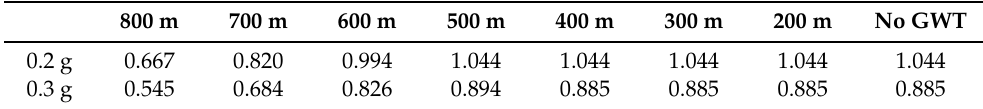
Figure 9. Sliding surfaces for different levels of the groundwater table under the seismic acceleration of 0.2 g (the slip surface corresponding to the GW table with black underlines in the legend is closest to the observed slip surface). Table 9. The safety factors of the slope under different initial groundwater table conditions for the seismic loading of 0.2 g or 0.3